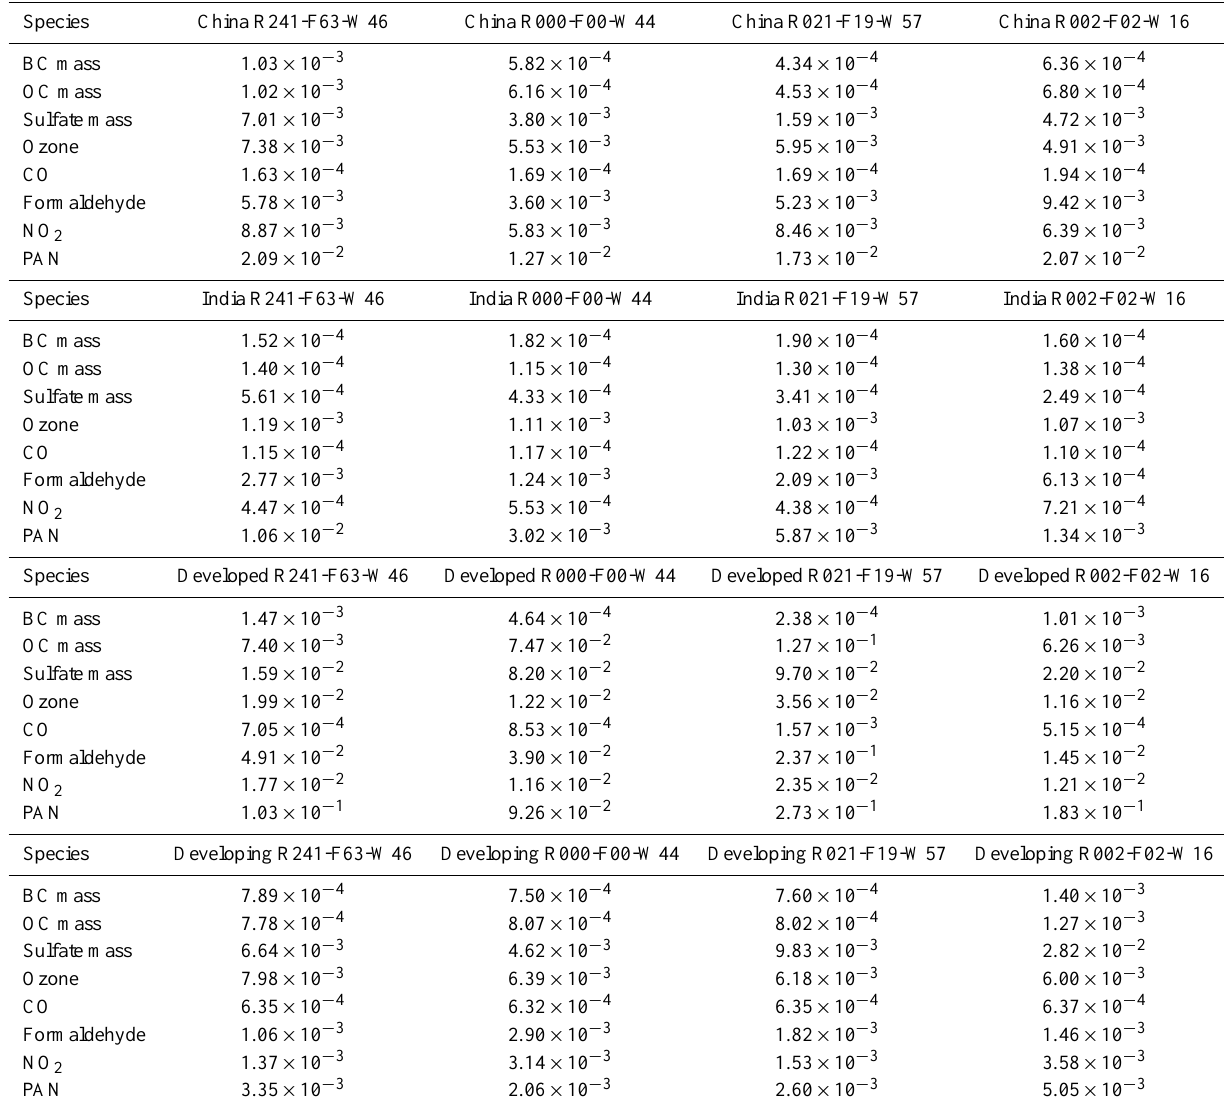
Table 7. Normalized fractional RMS errors for species mass fluxes through the boundaries of the urban area.